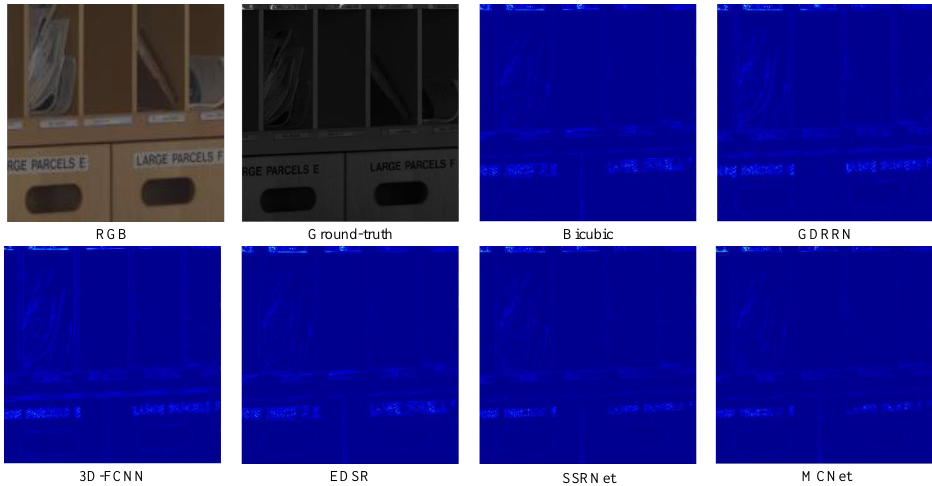
Figure 8. Absolute error map comparisons for image imgd5 on Harvard dataset.